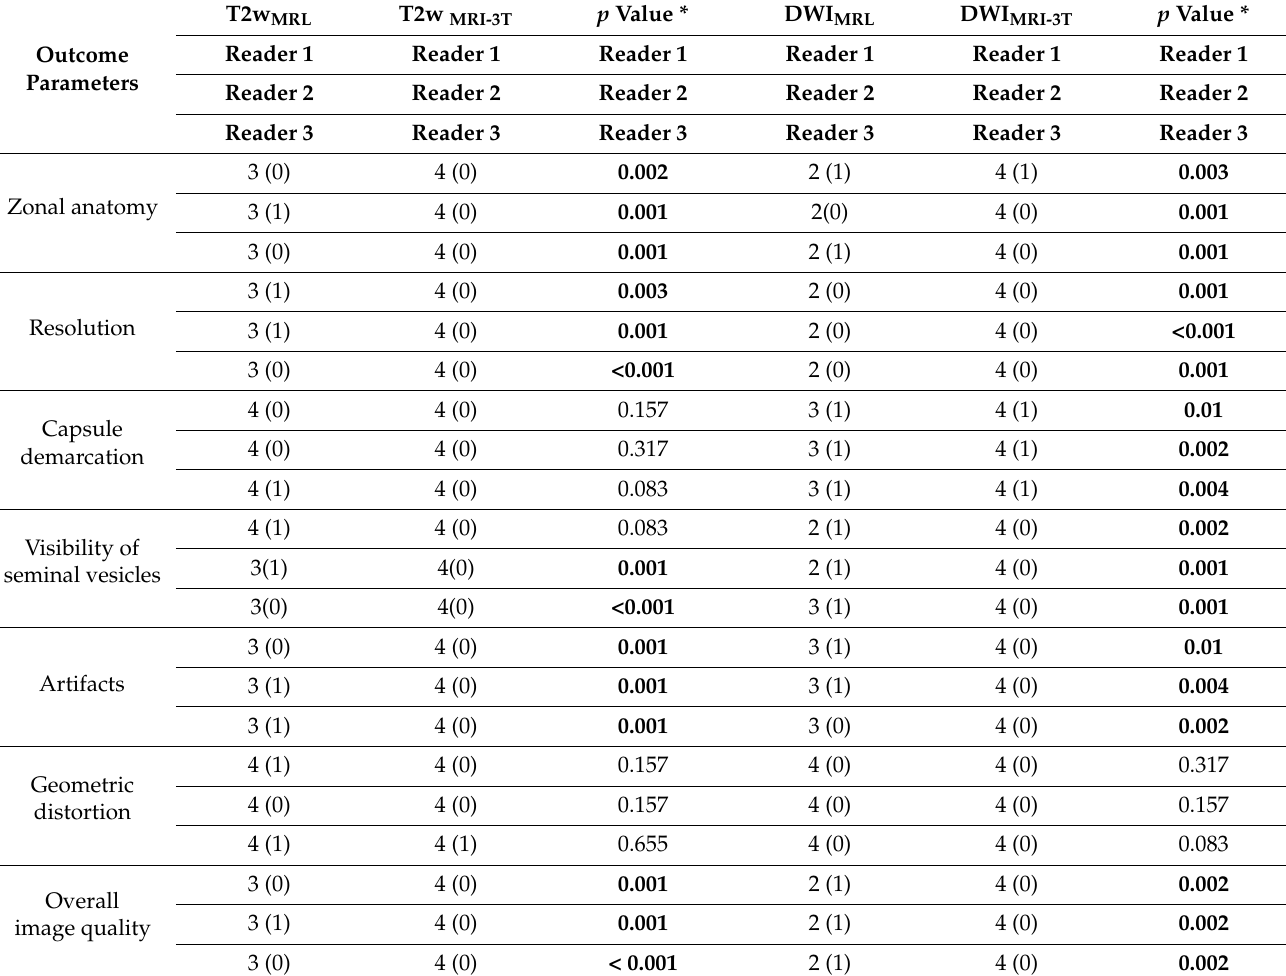
Table 3. Comparison of qualitative image criteria between MR-Linac (MRL) and standard MRI at 3T (MRI 3T ) for T2w and DWI